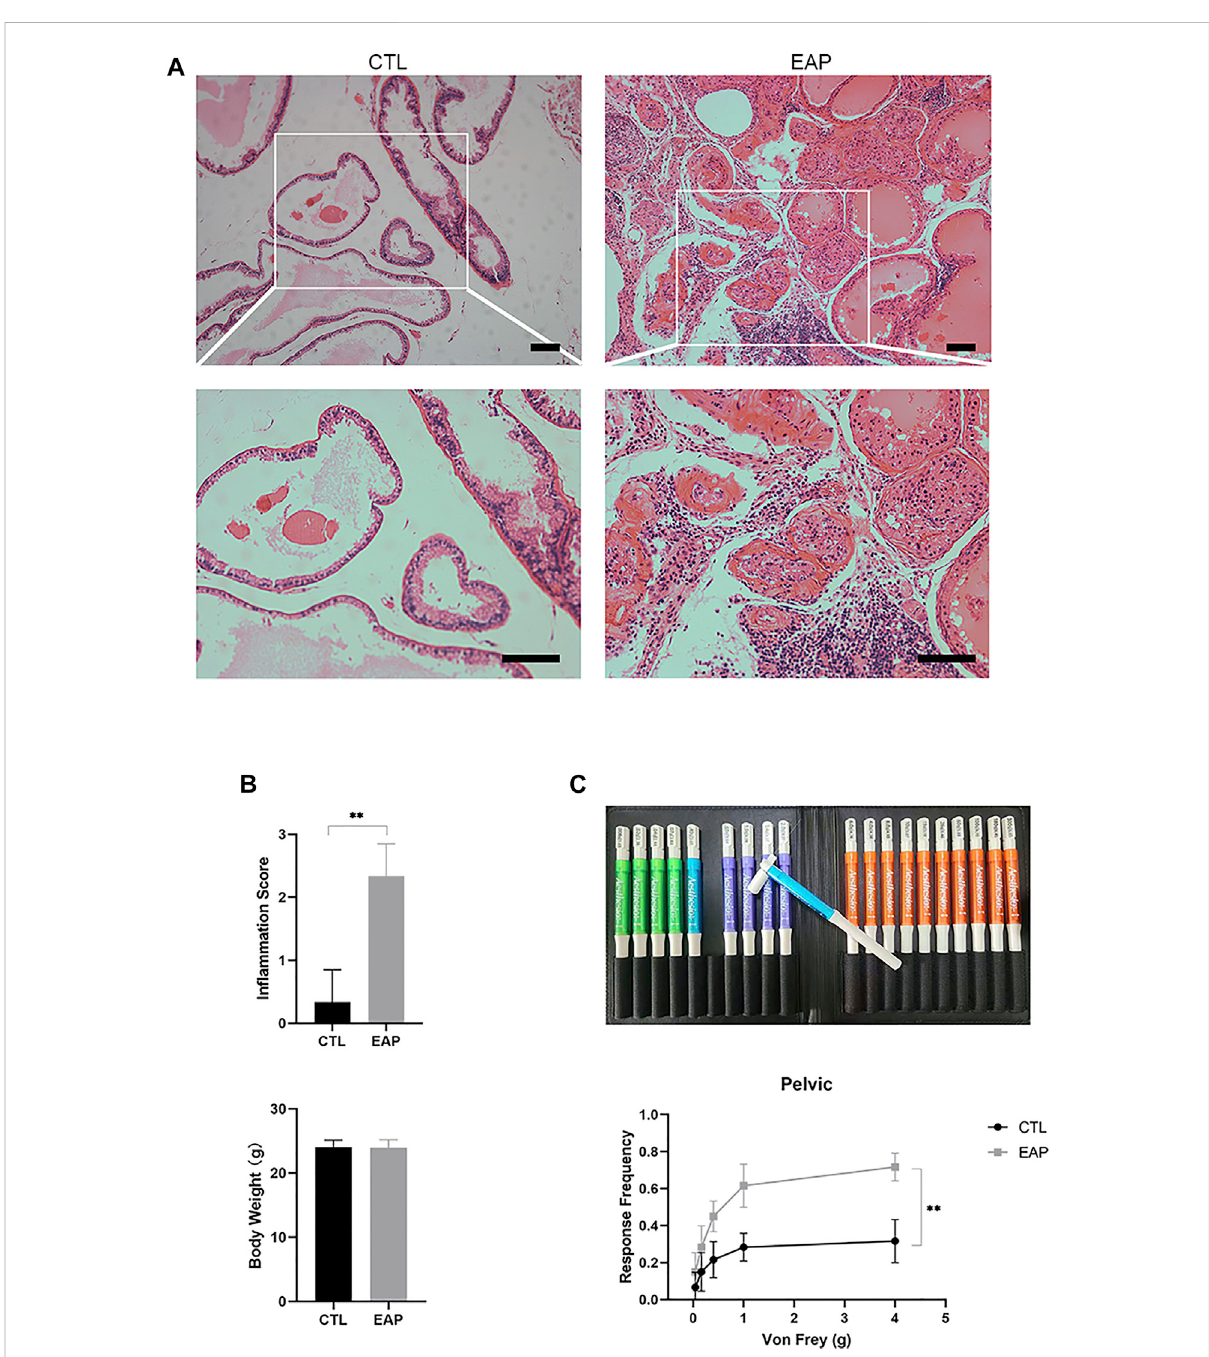
FIGURE 2 Successful establishment of the CP/CPPS mouse model. (A) Sections of prostate tissues were stained with HE. Scale bar = 50 μ m; CTL = control; EAP = experimental autoimmune prostatitis mice. (B) In fl ammatory score and weight in the CTL and EAP groups. n = 6. (C) The Von